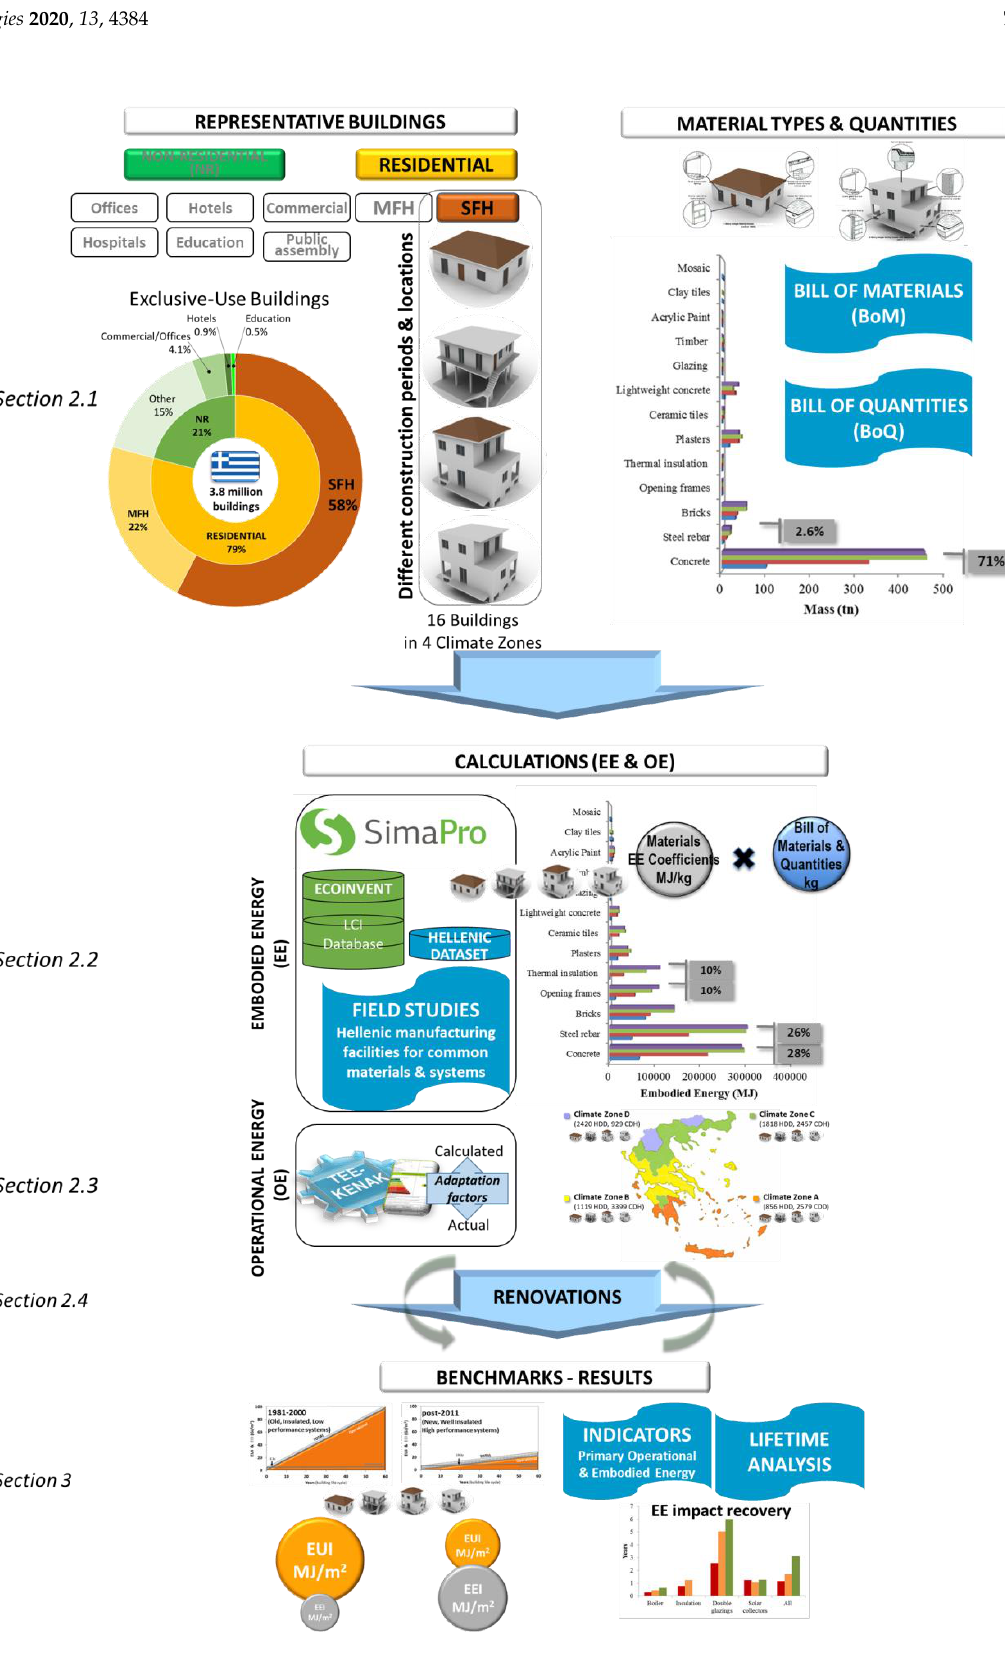
Figure 1. Methodological schematic of the work.